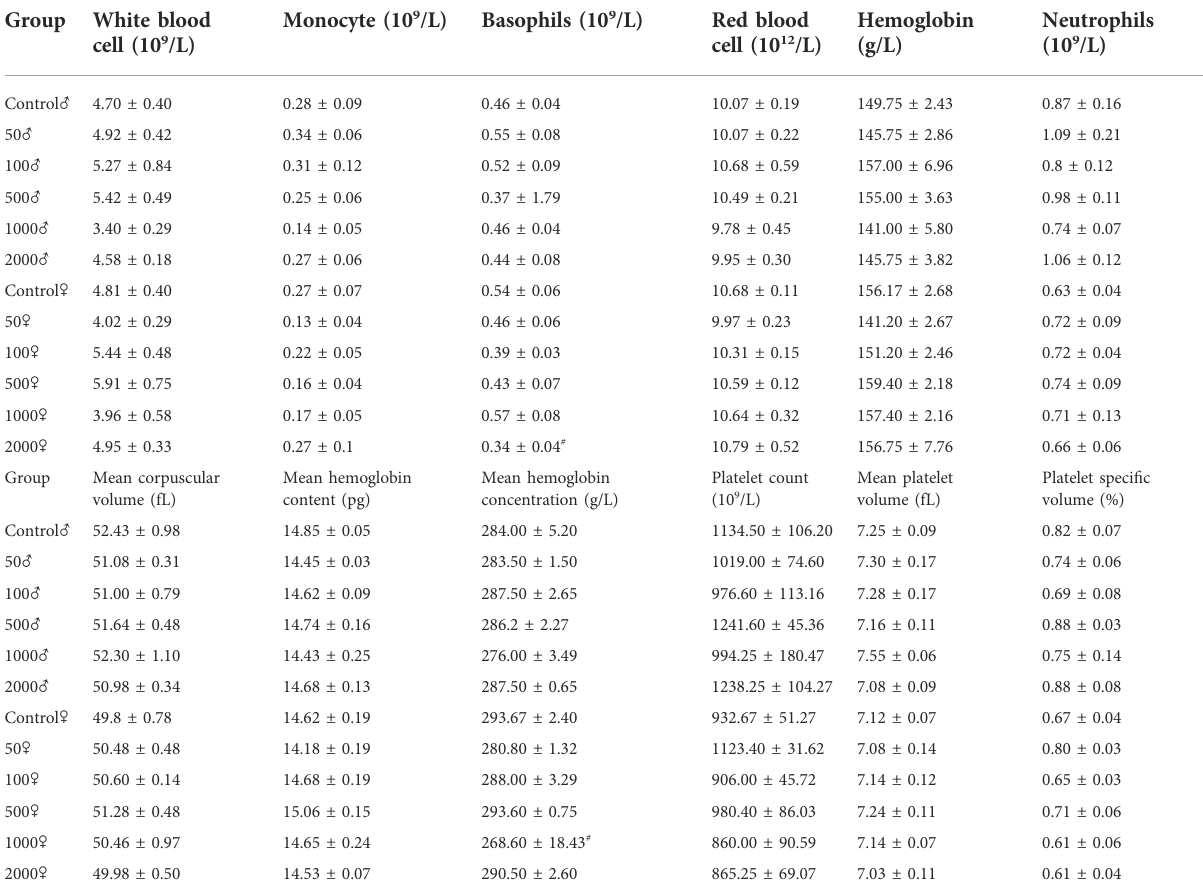
TABLE 1 Effect of NAY on blood routine in mice.